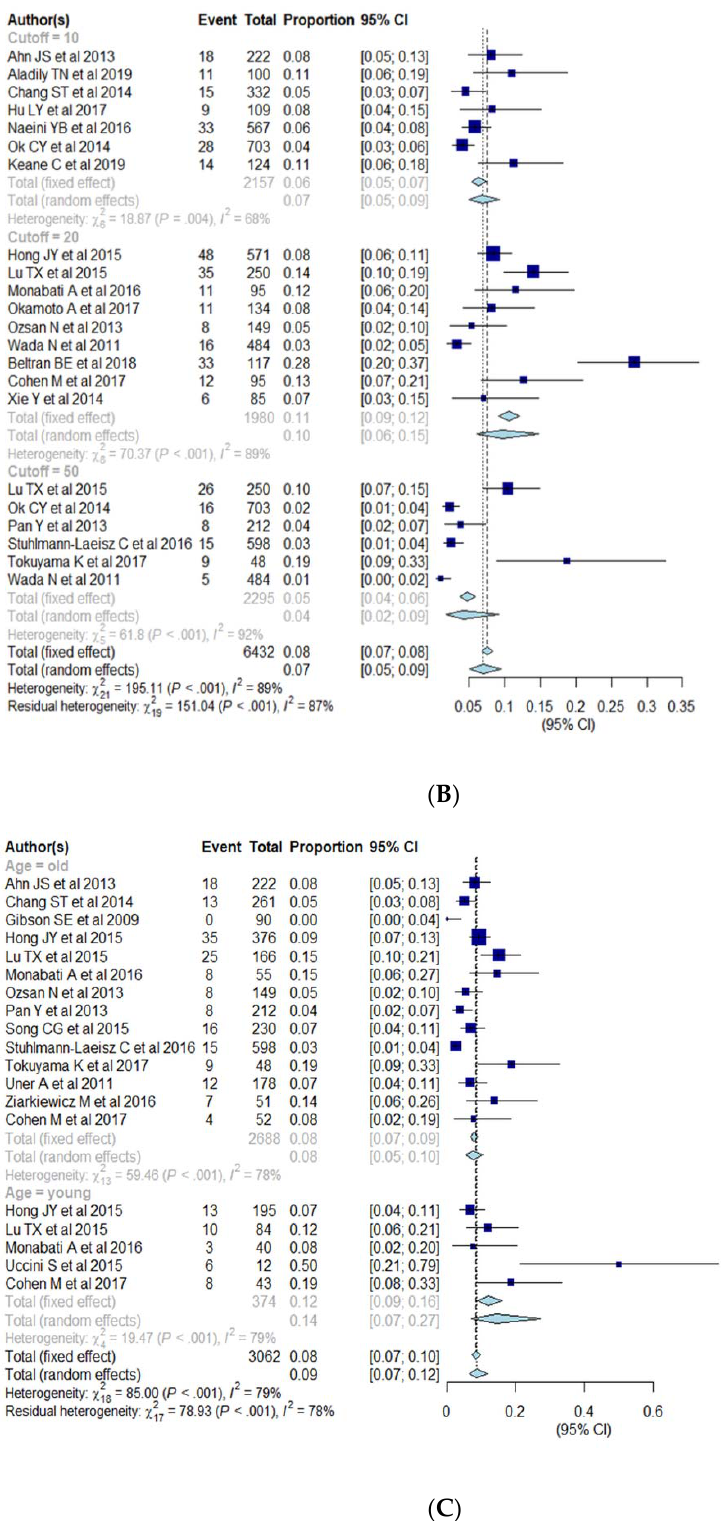
Figure 4. ( A – C ) Forest plots of the pooled proportions of EBER positive DLBCL. Subgroup analyses were according to race (Asia and South America vs. Western countries) ( A ), cut-offs for EBER positivity (10%, 20%, 50%) ( B ), and patients’ age (elderly ≥ 50 years vs. young <50 years) ( C ).